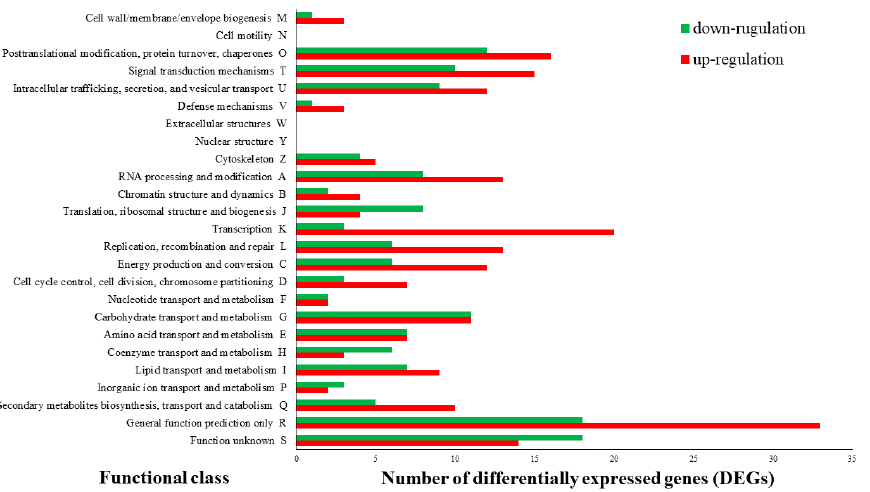
Figure 1. Gene set enrichment analysis (GSEA) of differentially expressed genes. Cytoscape and an enrichment map were used for visualization of the GSEA results.